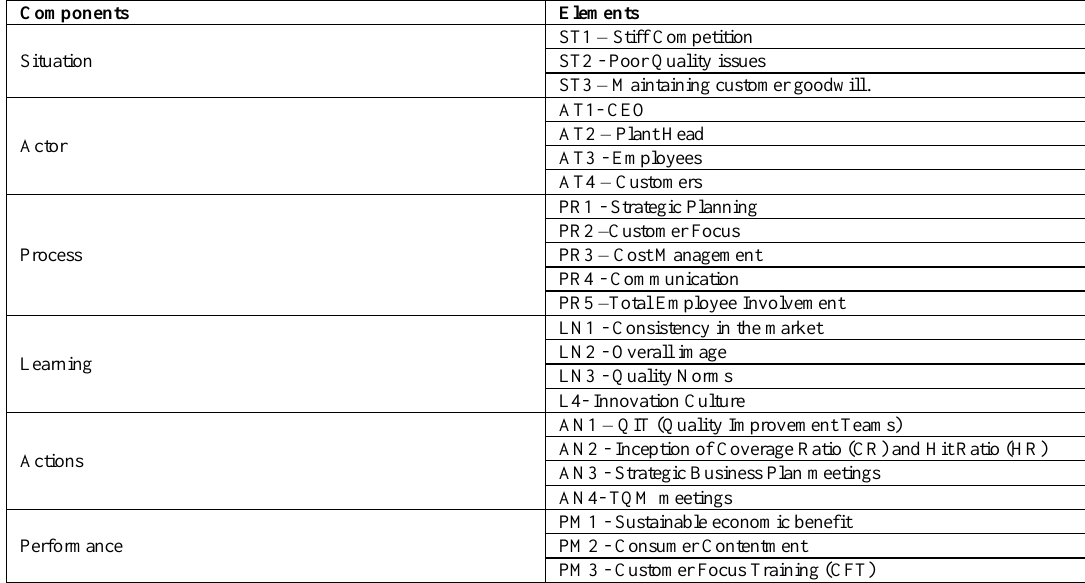
Table 1. Elements of SAP-LAP